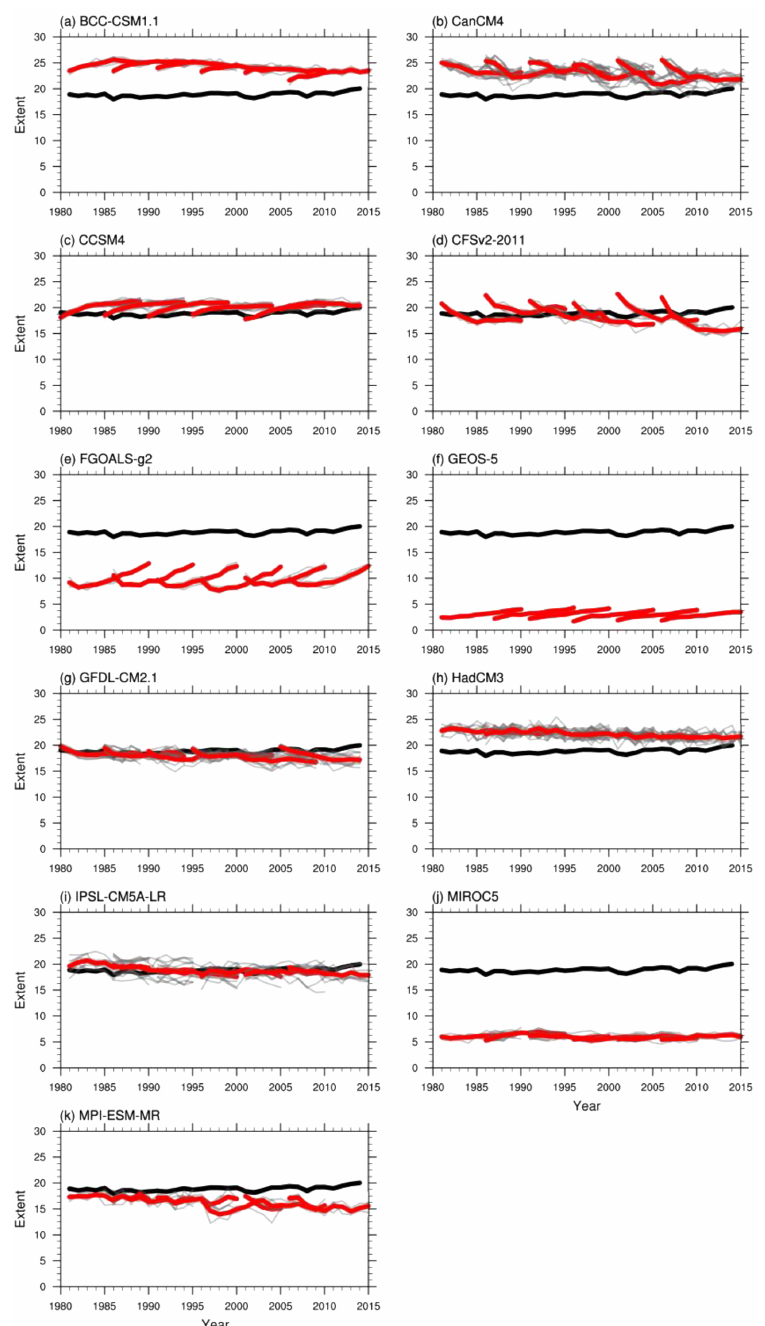
Figure 7. Time series of September Antarctic sea ice extent (seasonal minimum) from the simulations of the 10-year hindcast for each ensemble member of each individual model (thin gray line), the ensemble mean of each individual model (thick red line), and satellite observation (black line) from 1981 to